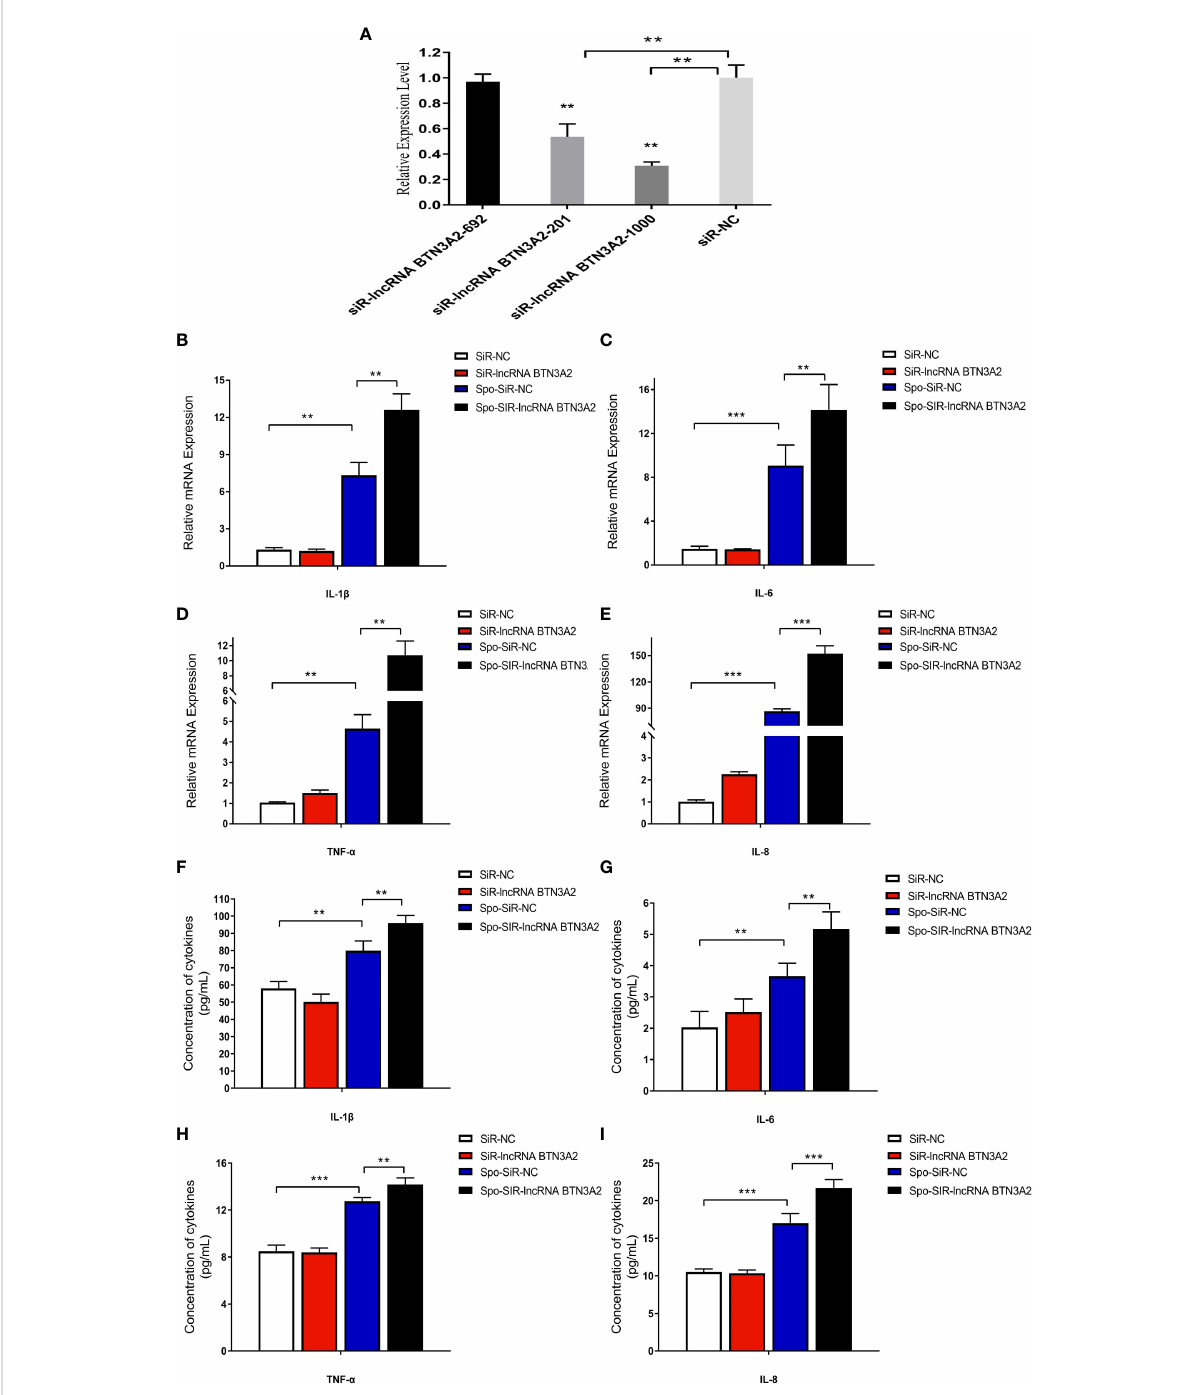
FIGURE 9 LncRNA BTN3A2 promotes the production of in fl ammatory cytokines in sporozoite-stimulated DF-1 cells. (A) Interference effect of three lncRNA BTN3A2 siRNA vectors after transfection with DF-1 for 24 h (B – E) After 24 h of transfection, the cells were stimulated with sporozoite for another 6 h, and the mRNA expression levels of IL-1 b (B) , IL-6 (C) , TNF- a (D) and IL-8 (E) were analyzed by qRT – PCR and normalized to b - actin. (F – I) After 24 h of transfection, the cells were stimulated with sporozoite for another 6 h, and the production of IL-1 b (F) , IL-6 (G) , TNF- a (H) and IL-8 (I) in the supernatant of DF-1 cells was demonstrated by ELISA. * P < 0.05, ** P < 0.01, and *** P <